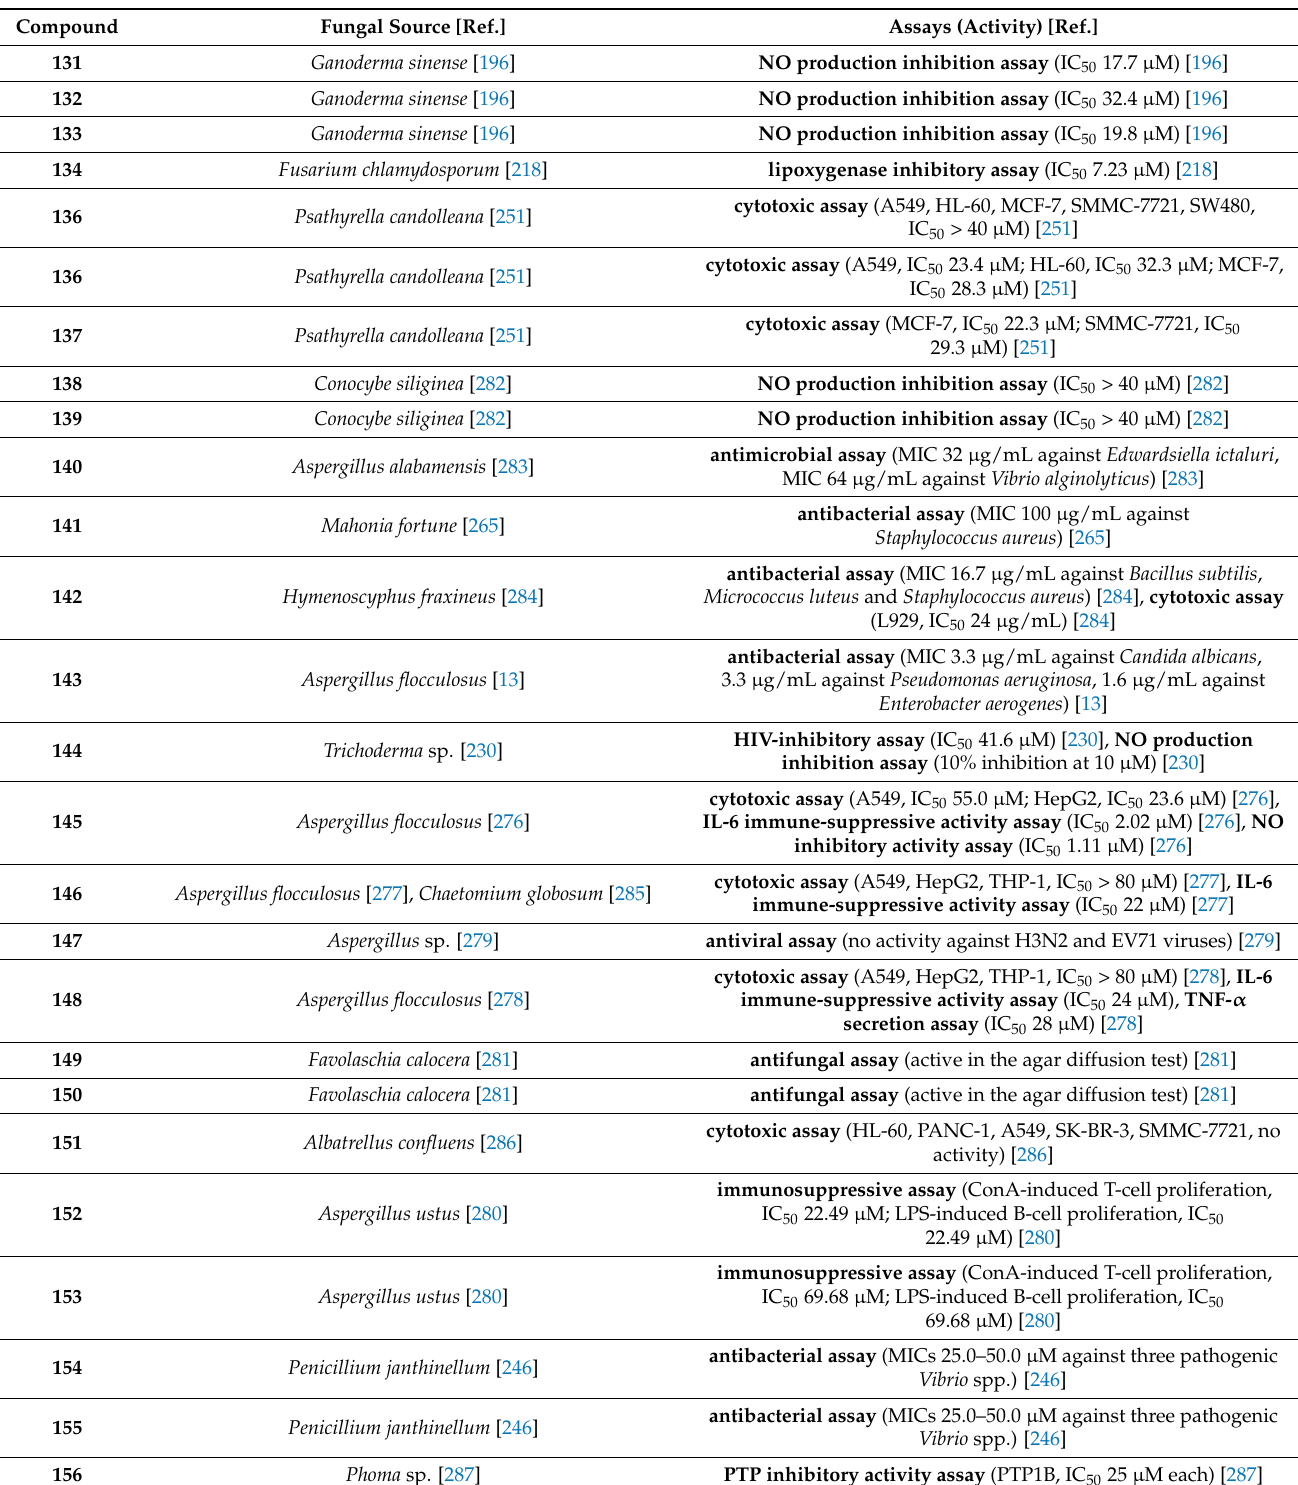
Table 6. Sources and biological activity of fungal steroids with a transformed side chain. Fungal Source